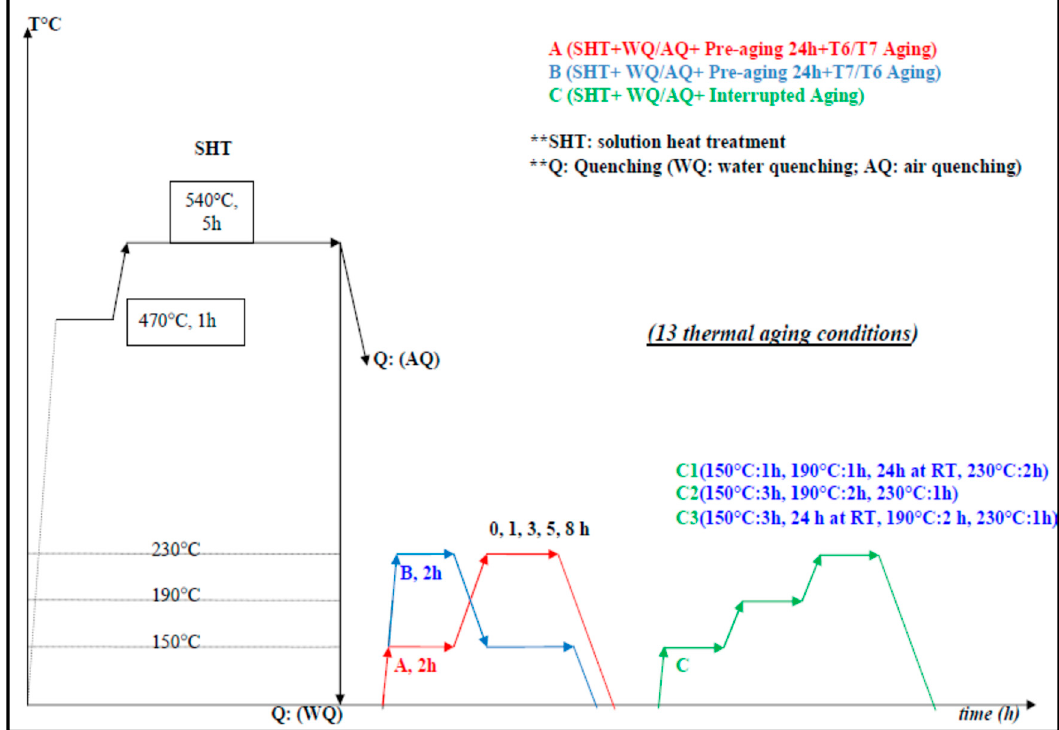
Figure 1. Multiple-Interrupted temperatures aging treatments employed for A357 semi solid alloys.